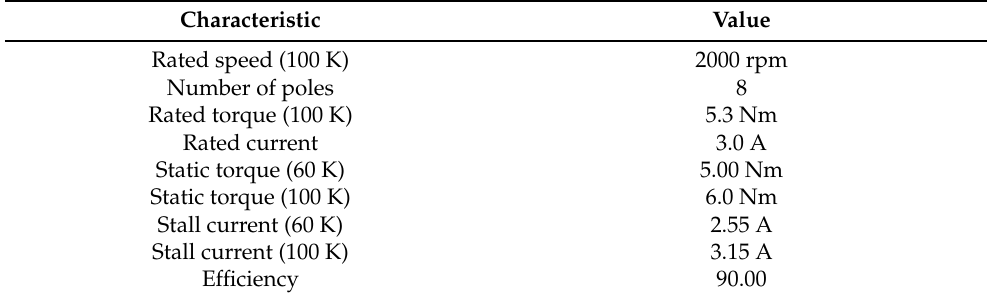
Table 2. PMSM motor parameters. The motor part number is S 1FK7060- 2AC71-1CA0 provided by Siemens. The numbers 60 K and 100 K refer to overtemperature values of 60 K and 100 K.